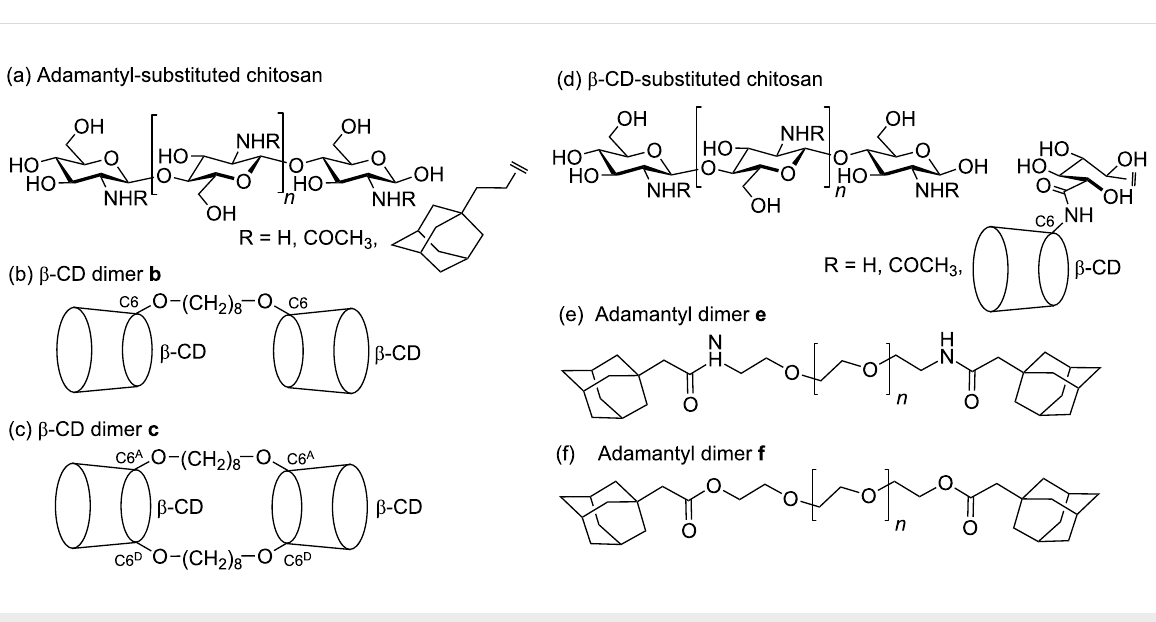
and related β -CD [79,80] dimers in aqueous solution. It